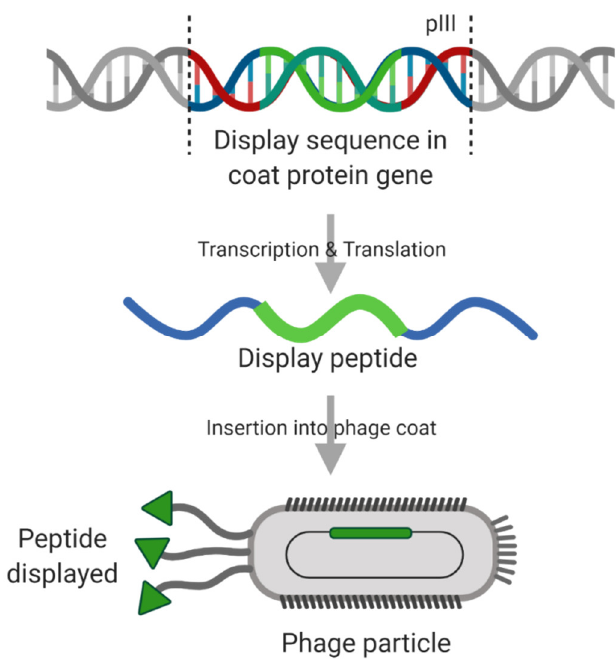
Figure 7. M13-based phage display mechanism. Created with https: // BioRender.com.